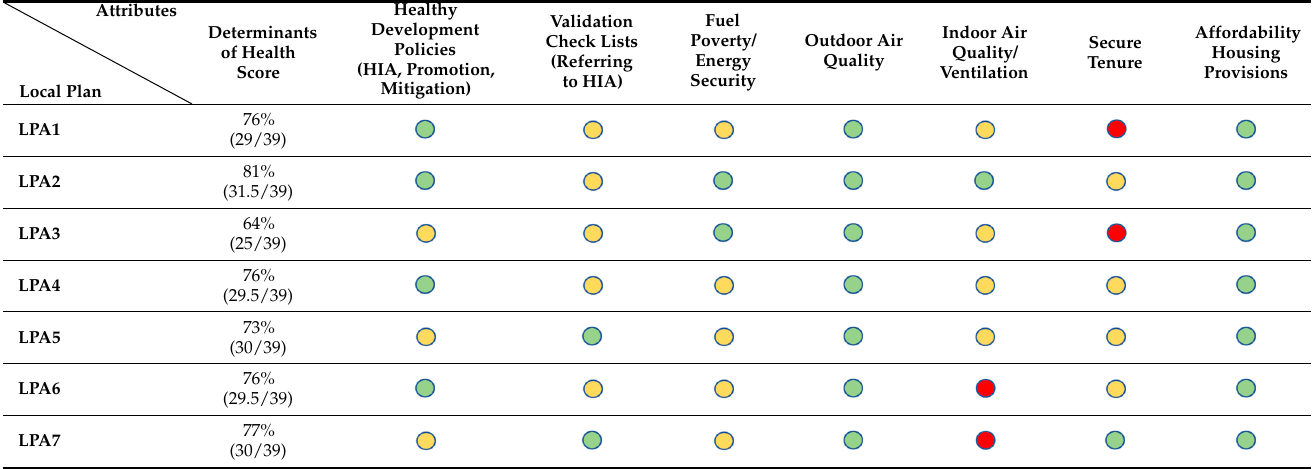
Table 3. Local plans and health requirements for developers.